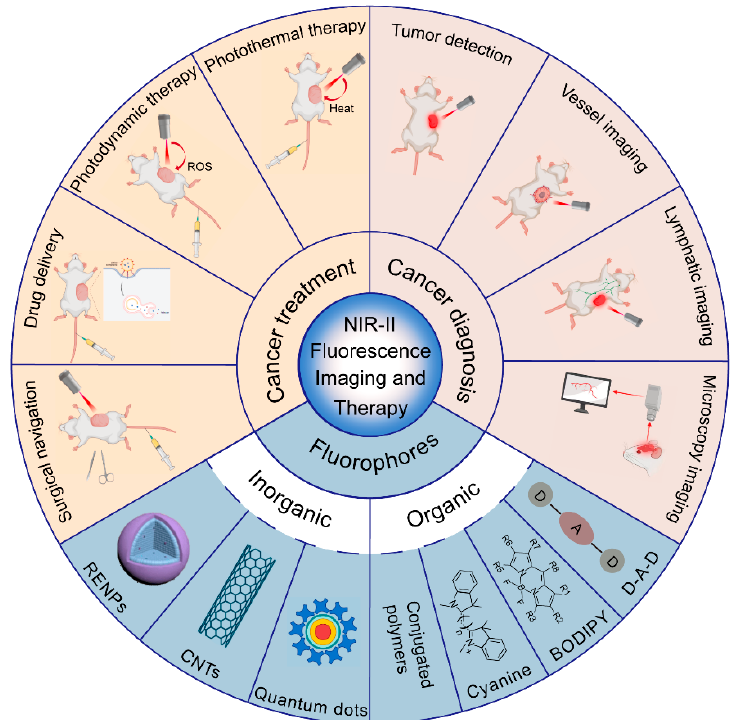
Figure 1. Summary of the categories of NIR-II fluorophores and applications for NIR-II fluorescence imaging in cancer diagnosis and therapy (created with BioRender.com, accessed on 27 July 2022).